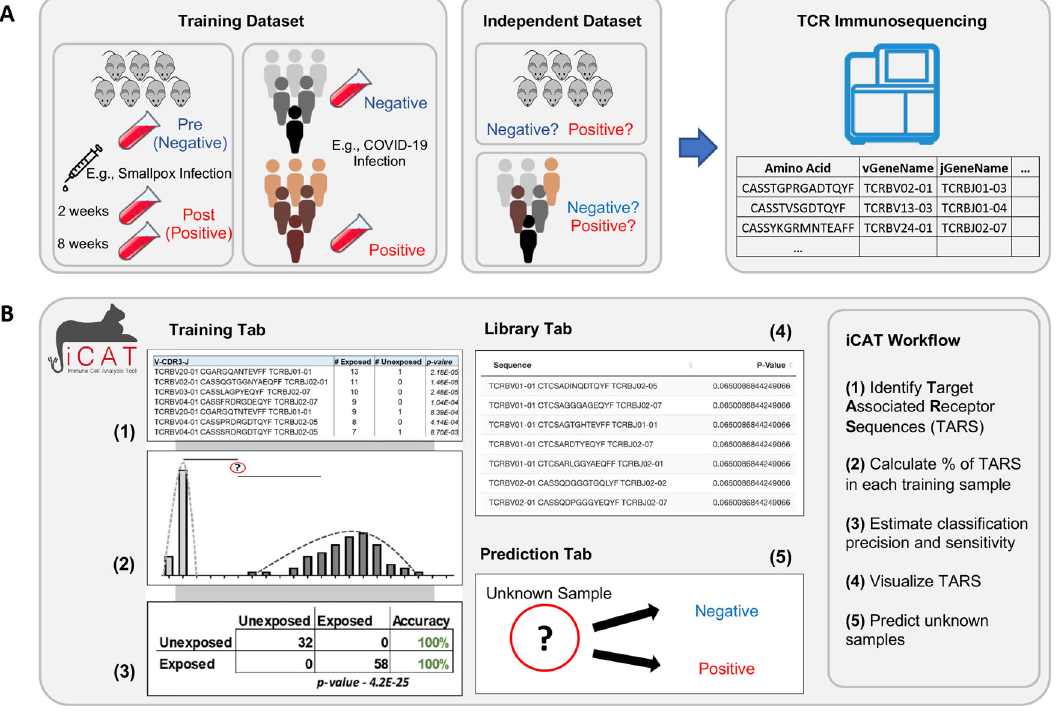
Figure 1. Workflow for TCR repertoire sequencing and diagnostic assessment of prior antigen exposure using iCAT. A)FlowchartdepictingthepurificationofDNAfrombloodsamplesandtheproductionofTCRrepertoiresafter TCR-specific amplification and sequencing. B) Visual representation of the iCAT